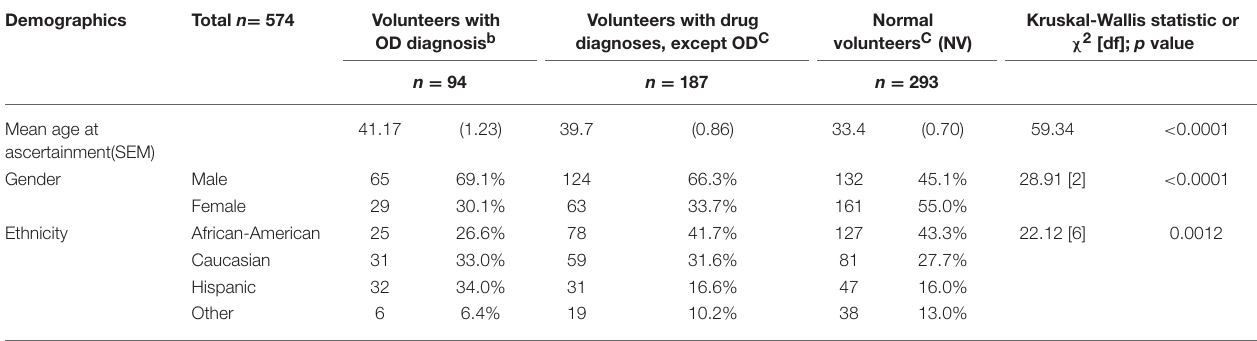
TABLE 3 | Demographics (volunteers sequentially ascertained 4/4/02-8/1/13) a . (A) Comparison of volunteers with opioid dependence (OD) diagnoses, volunteers with drug diagnoses except OD, and normal volunteers.